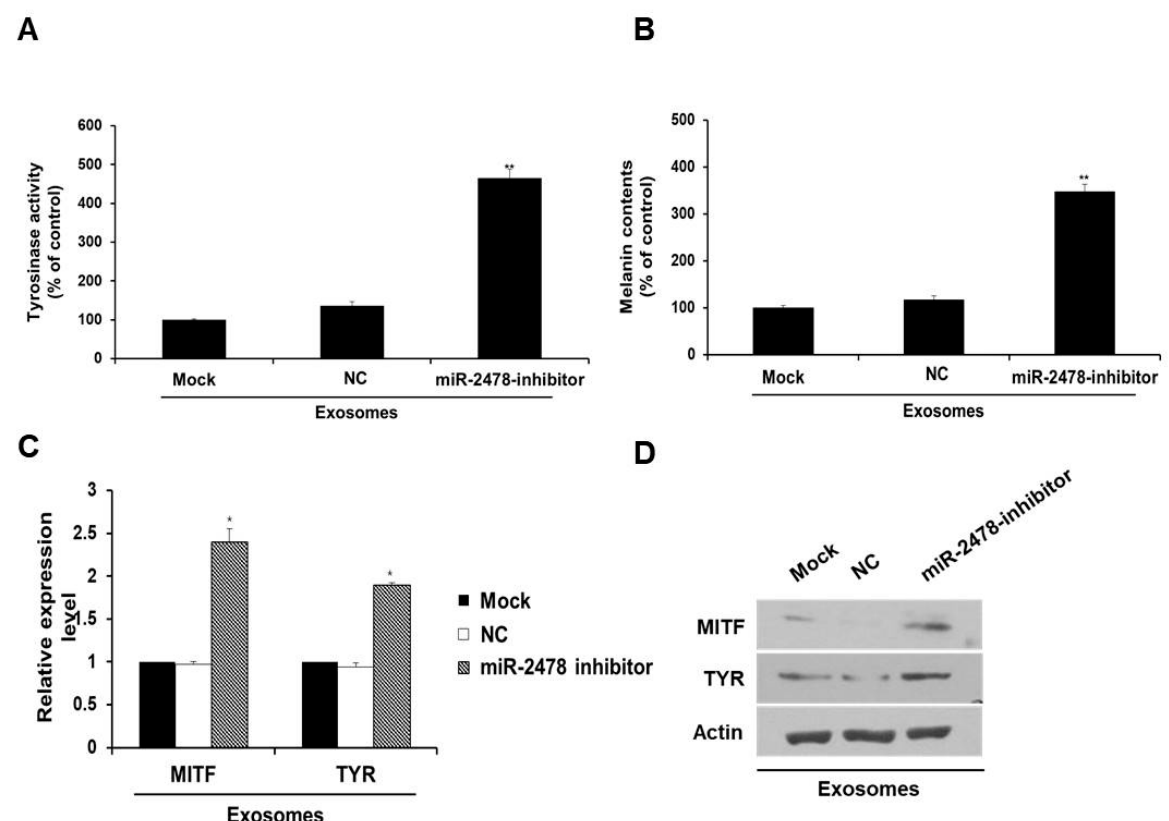
Figure 4. Silencing of miR-2478 recovers melanogenesis in milk exosome-treated cells. ( A , B ) Tyrosinase activity and melanin contents in the cells treated with the negative control (NC) or the miR-2478 inhibitor were analyzed in the presence of 50 µ g/mL of exosomes; n = 3, ** p < 0.01. ( C , D ) Expression of MITF and TYR was measured in NC or miR-2478 inhibitor-transfected cells with milk exosomes, as assessed by qRT-PCR and Western blotting; n = 3, * p < 0.05.